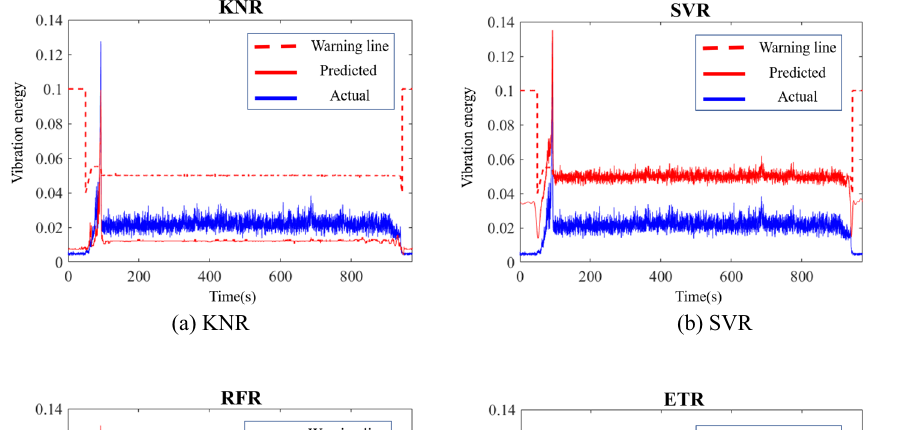
Fig. 9 Prediction of vibration energy by different